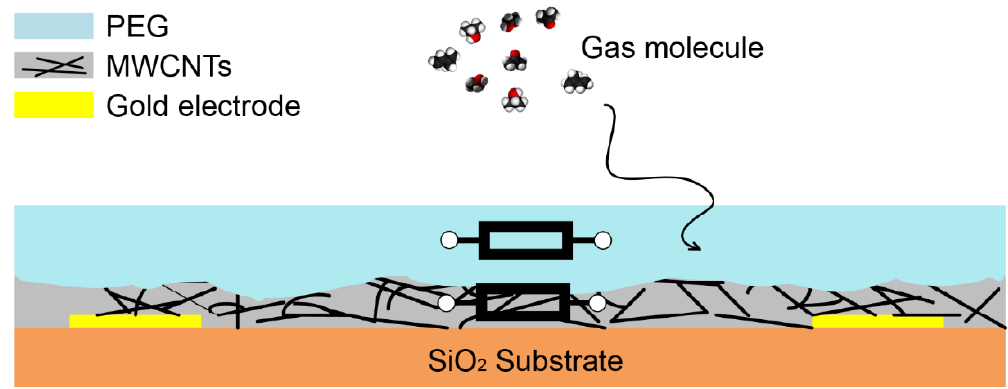
Figure 1. Schematic of the sprayed MWCNTs-PEG composite chemiresistive gas